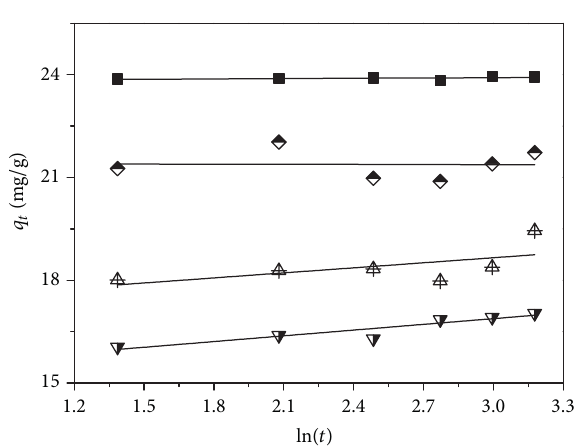
Figure 3: Elovich model for the adsorption of strontium ions on samples A (solid square), B (half-filled diamond), C (center up triangle), and D (half-filled down